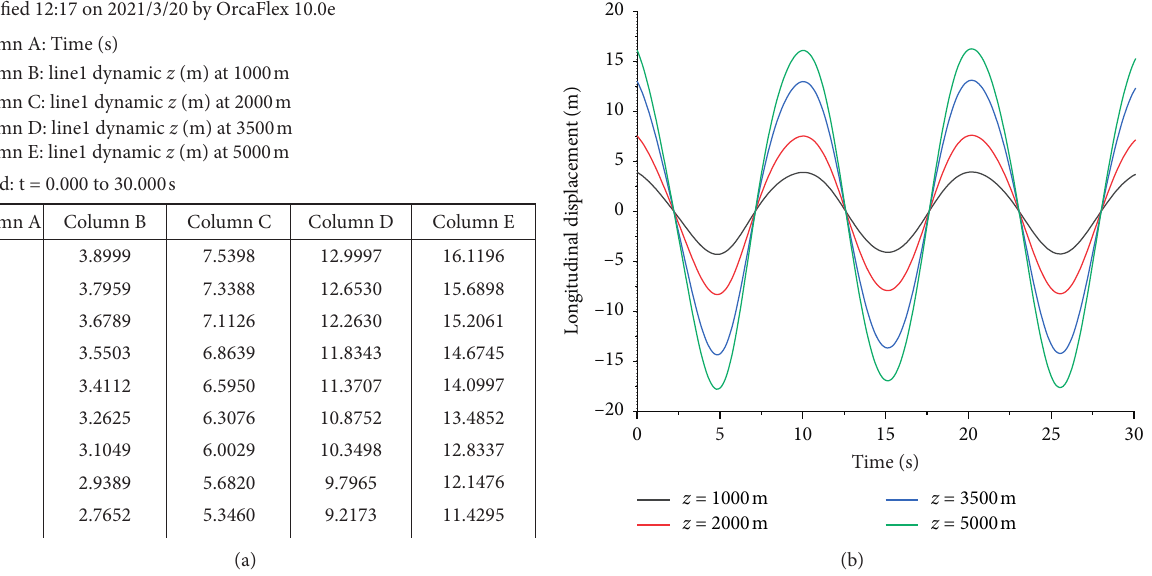
Modified 12:17 on 2021/3/20 by OrcaFlex 10.0e